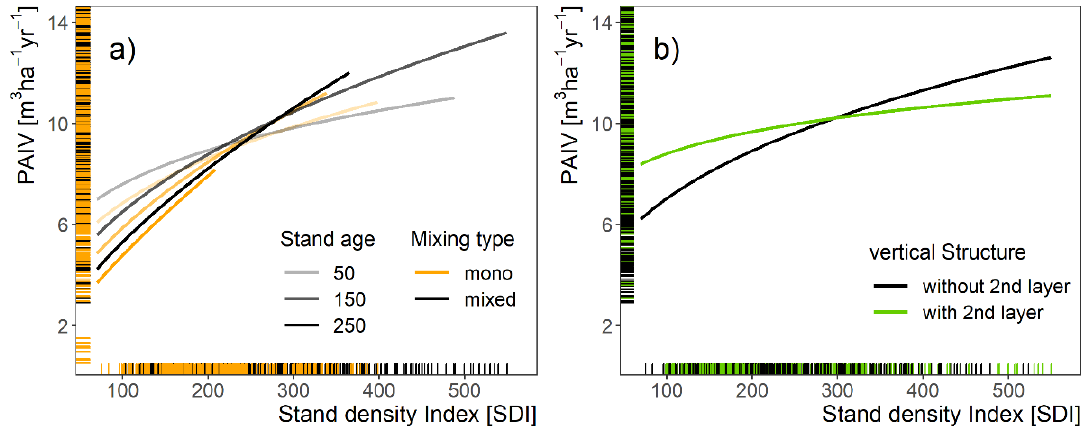
Figure 2. Stand productivity for monospecific and mixed oak stands as a function of stand density, stand age and mixing type ( a ) and as a function of stand density and vertical structure ( b ); rugs on the x-and y-axis indicate the observed values of SDI and stand productivity, respectively; all other variables were set to their mean.